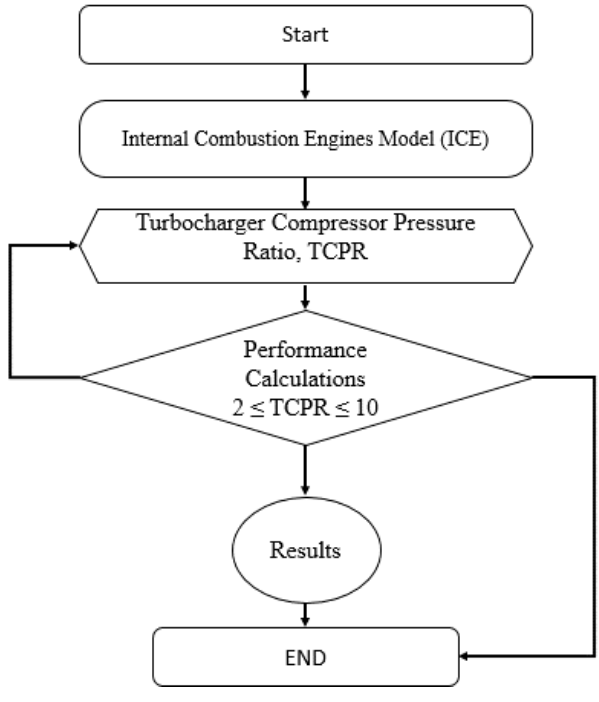
Figure 3. Methodology flowchart